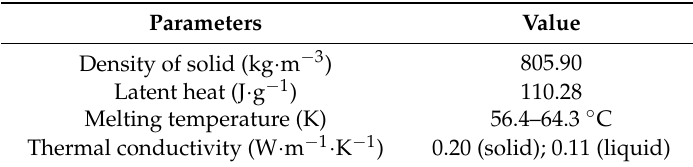
Table 1. Thermophysical properties of paraffin RT